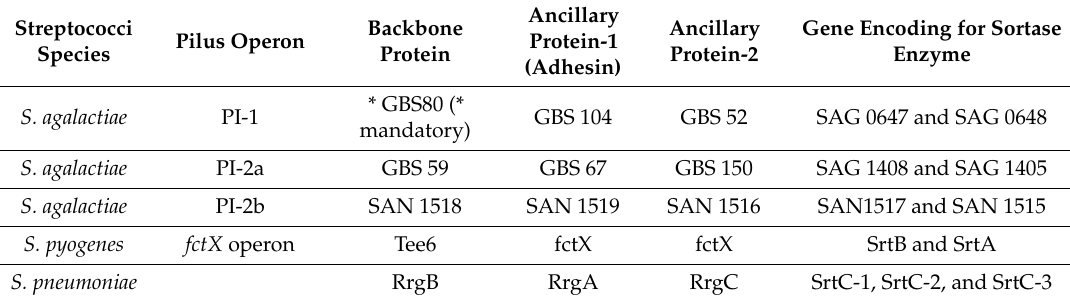
Table 2. Genomic distribution of di ff erent pilus island in di ff erent Streptococci